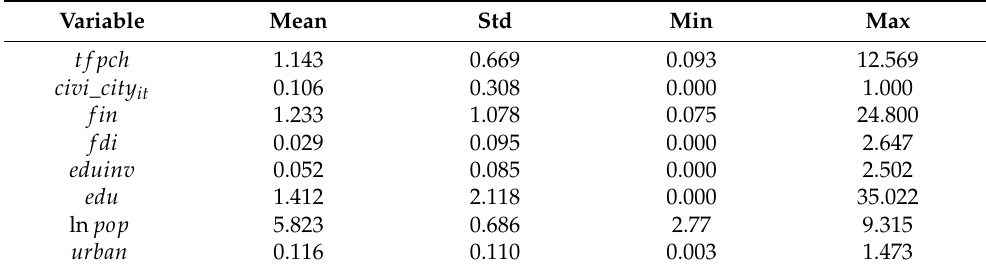
Table 1. Descriptive